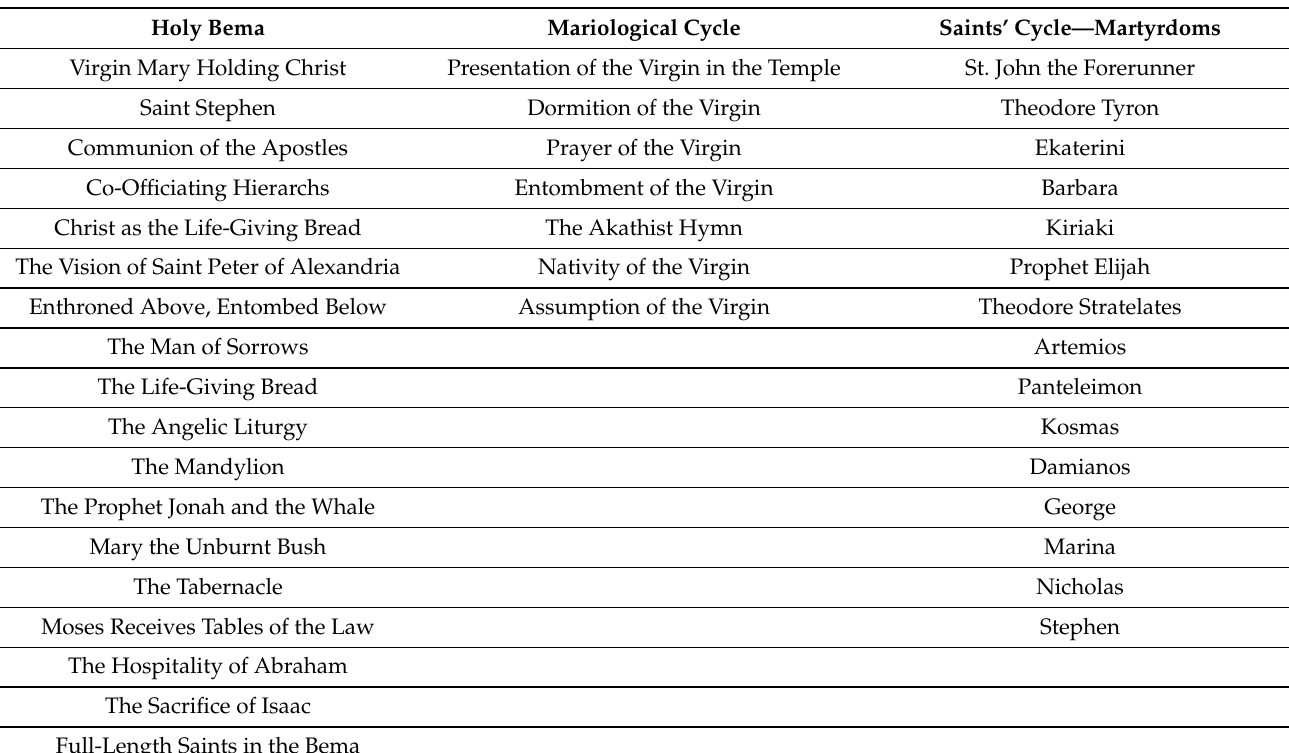
Table 2. The Holy Bema, the Mariological Cycle and Saints’